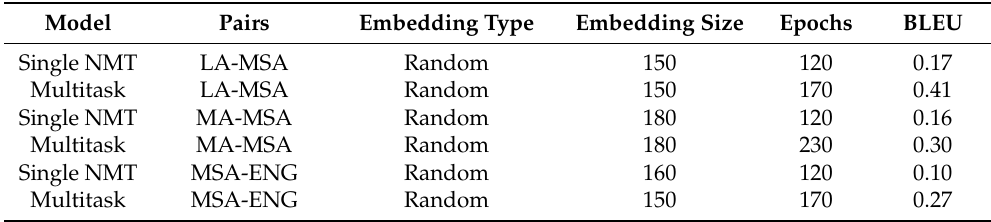
Table 3. Results of Multi-Task NMT with shared decoder in terms of BLEU score